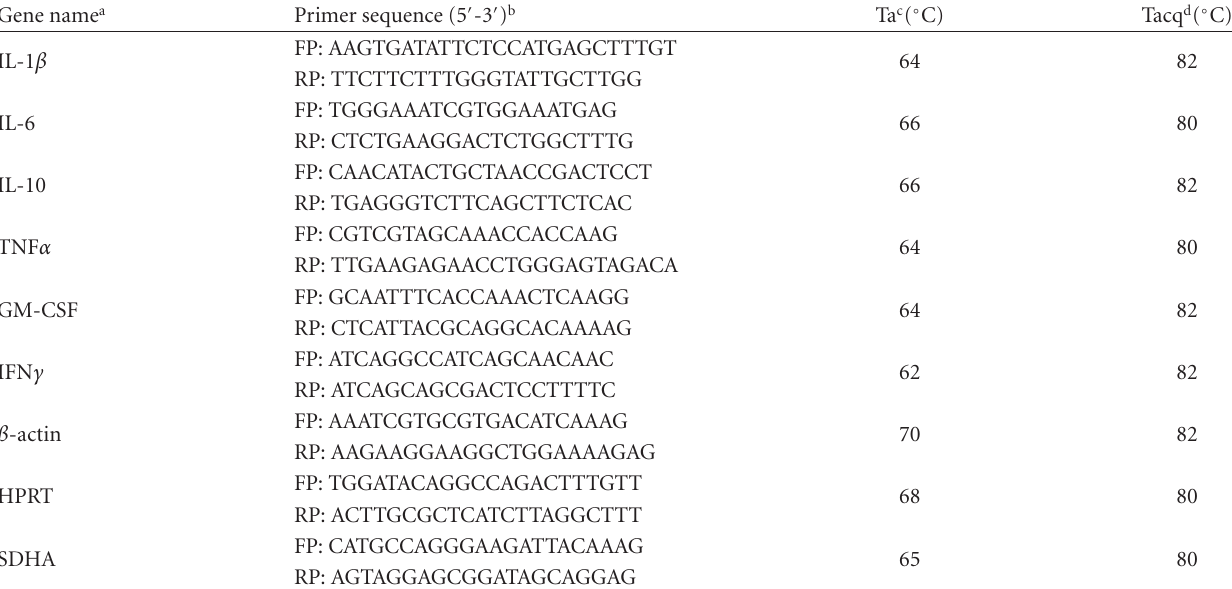
Table 2: Oligonucleotide primers for real-time